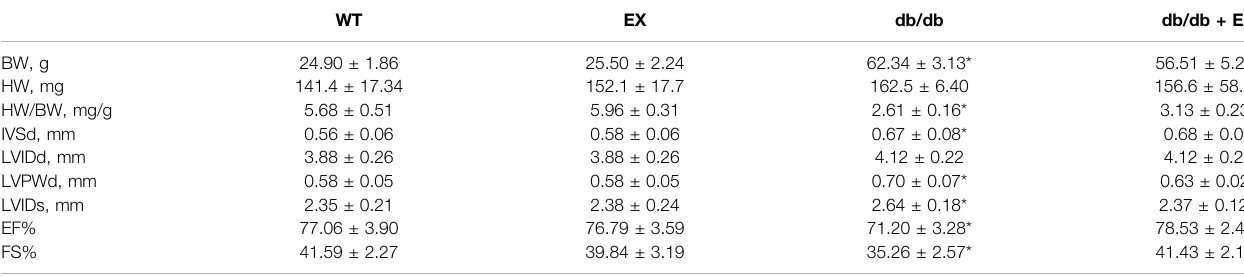
TABLE 2 | Cardiac function indexes of mice in each group (±SD, n =